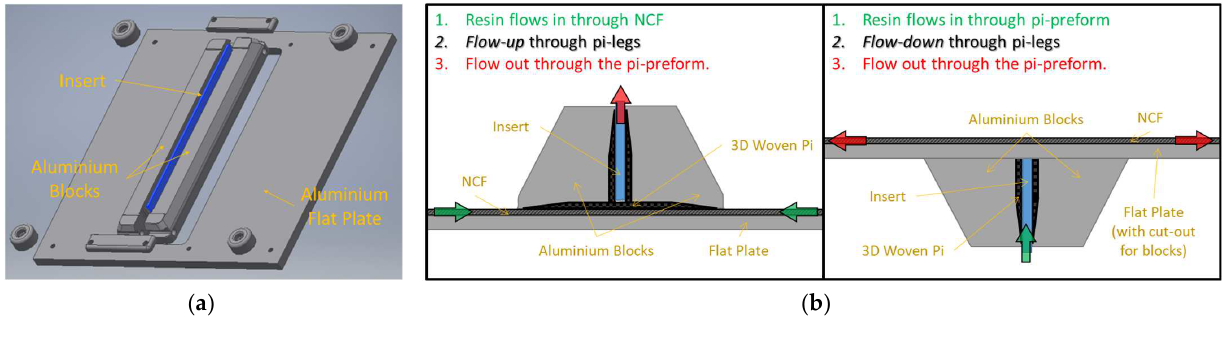
Figure 1. ( a ) Modular infusion tool design; ( b ) Flow “up” and “down” infusion set-ups with red and green arrows representing direction of resin flow. Table 2. Manufacturing parameters and data for pi-NCF infusions.